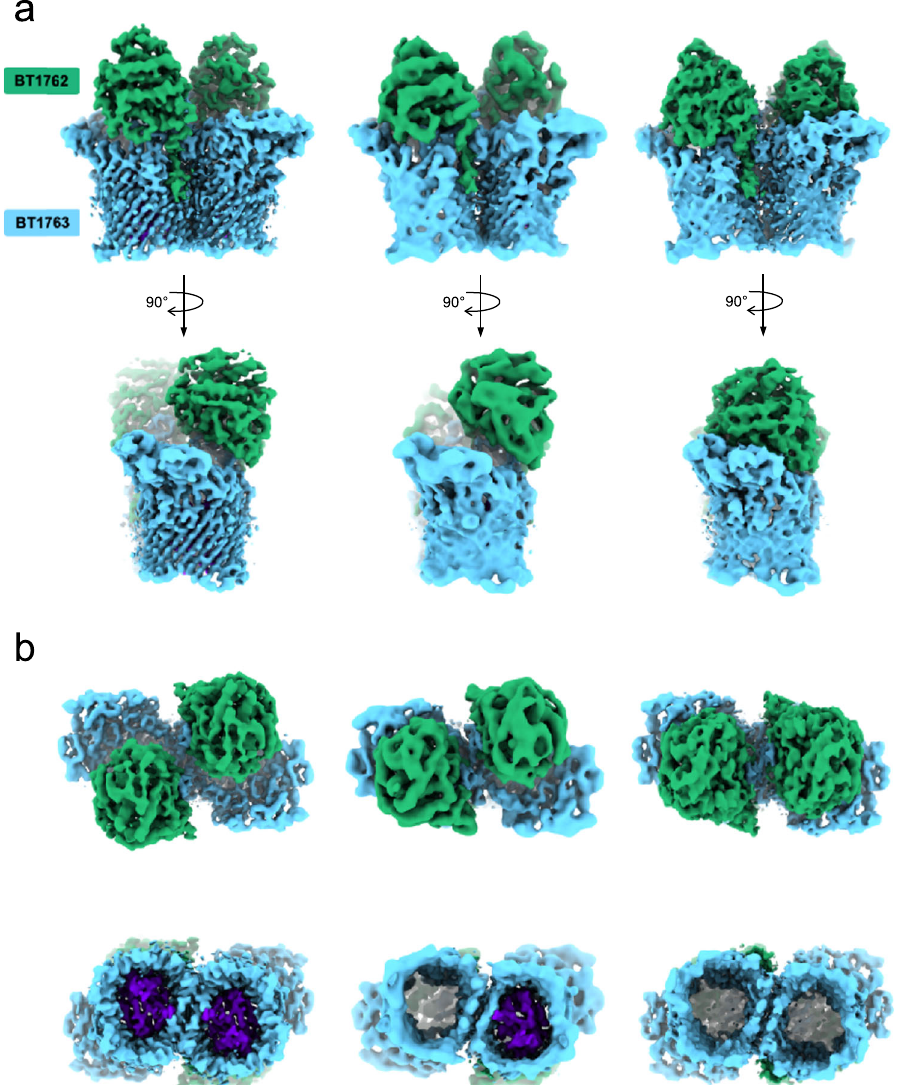
Fig. 3 Dynamics of pedal bin opening revealed by single-particle cryo-EM. a Electron density fi ltered by local resolution for Bt1762-63 viewed from the OM plane for the OO state (left panels), OC state (middle panels) and CC state (right panels). b Presence or absence of the Bt1763 SusC plug domain in the three principle states from cryo-EM. Local resolution fi ltered EM density for Bt1762-63 in the open-open (left), closed-open (middle) and closed-closed (right) states as viewed from the extracellular (top panels) and periplasmic side of the outer membrane (bottom panels). Clear density for the plug domain (purple) is invariably associated with the open state of the transporter. Where the lid is closed, no density is observed within the barrel of Bt1763. Cryo-EM fi gures were made with ChimeraX 65